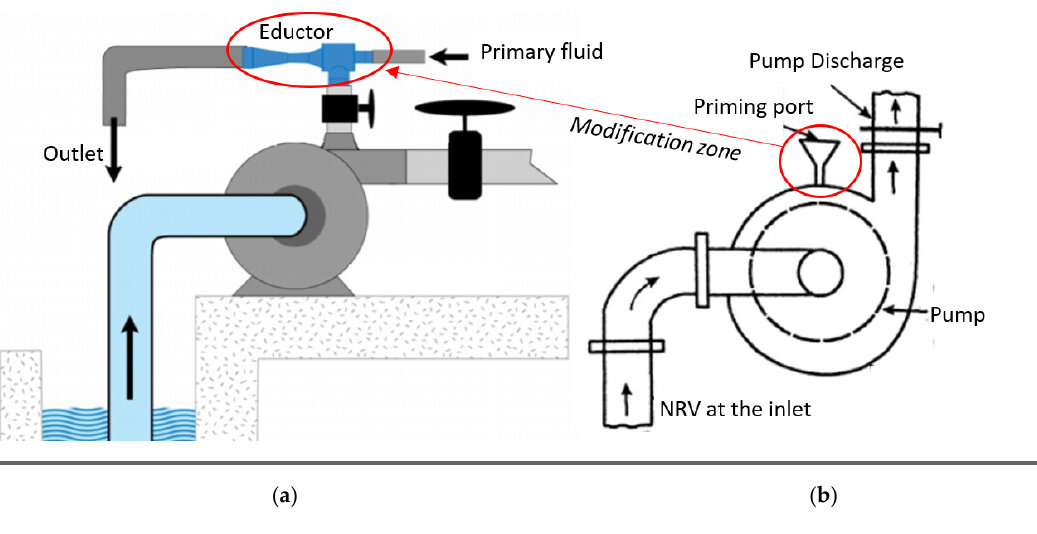
Figure 3. ( a ) Ejector priming, ( b ) manual priming (source [40])